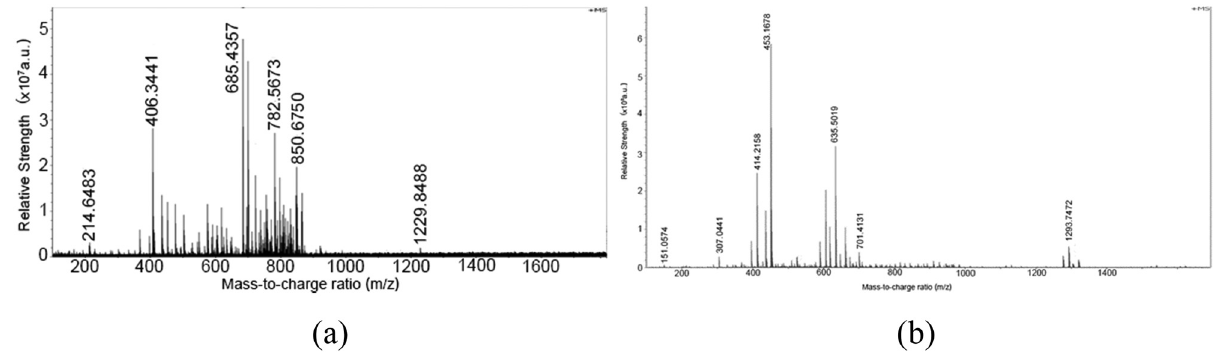
Figure 5: The positive mass spectrum of the lower layer ( a ) and the upper layer ( b ) of the sample extracted with the B&D